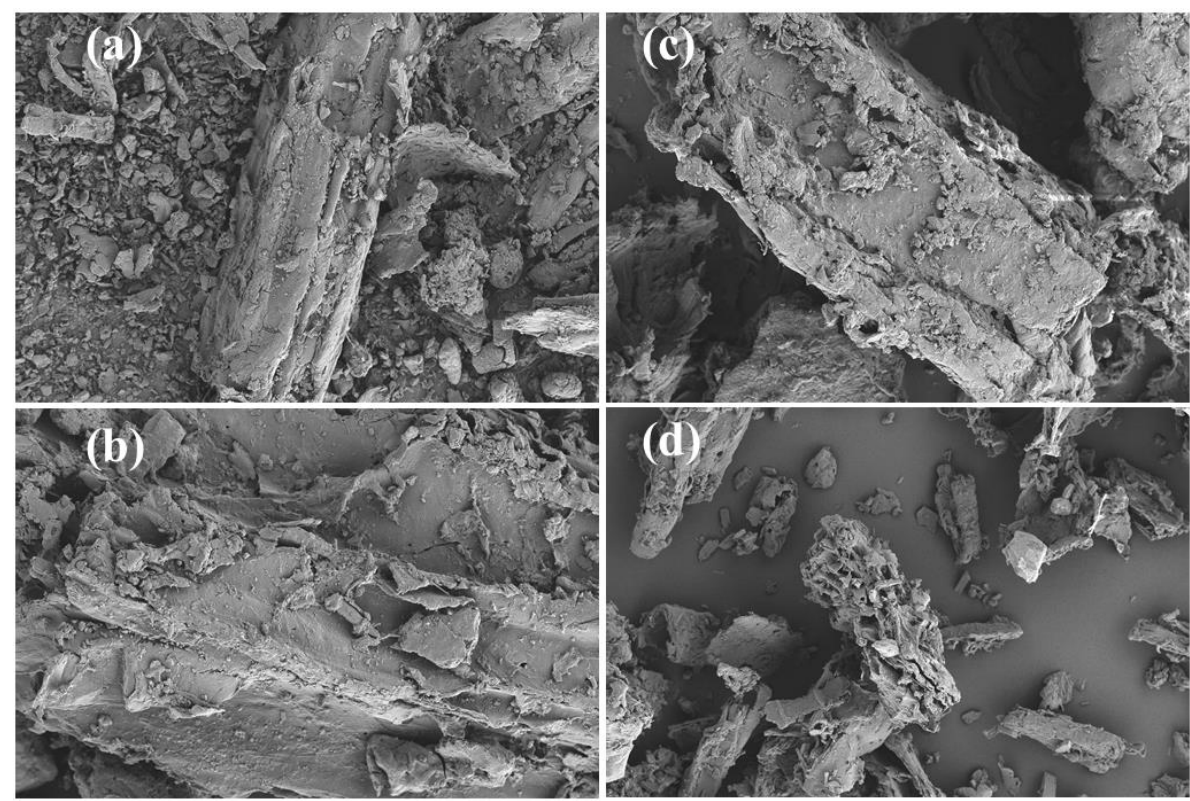
Figure 3. SEM image of ( a ) raw and pretreated ( b ) AH, ( c ) TH, and ( d ) TCH solid residues of SMS.